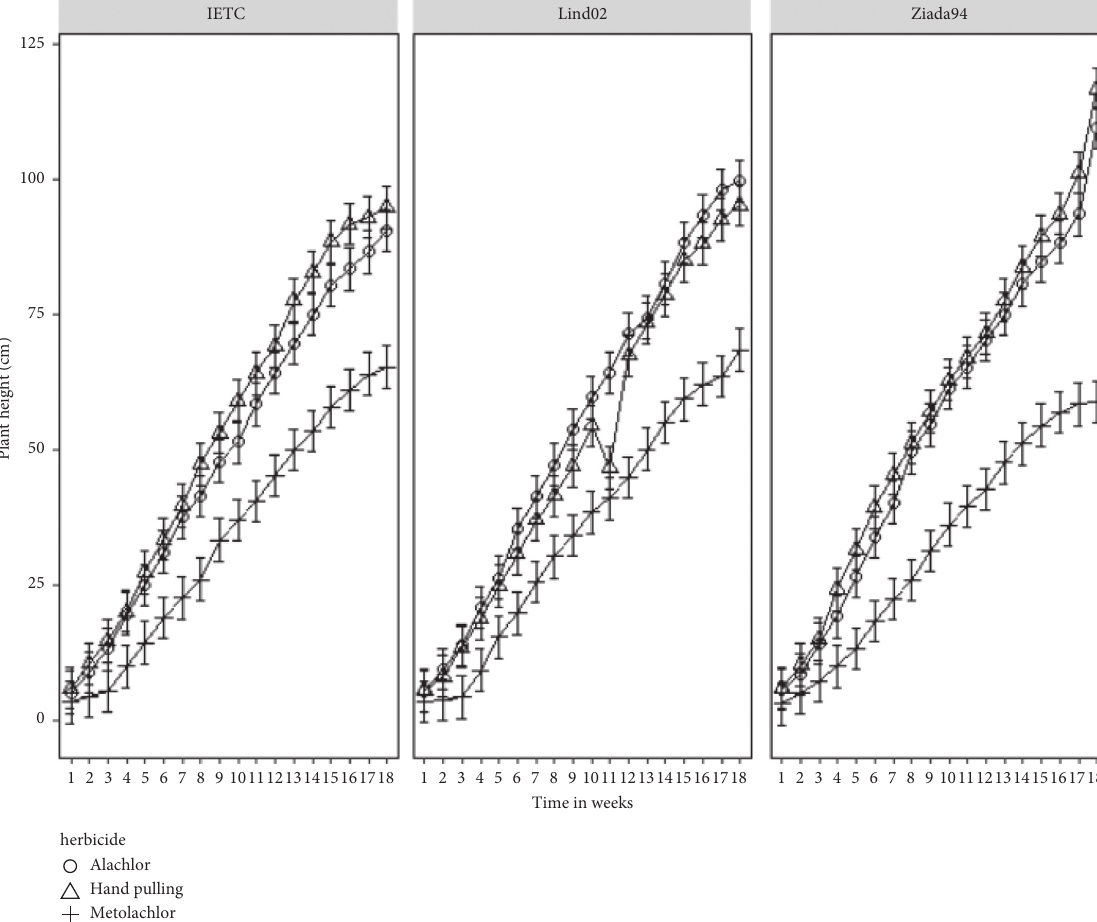
Figure 2: Effect of different preemergence herbicides on plant height of three sesame varieties. Error bars represent LSD at p < 0 . 05.